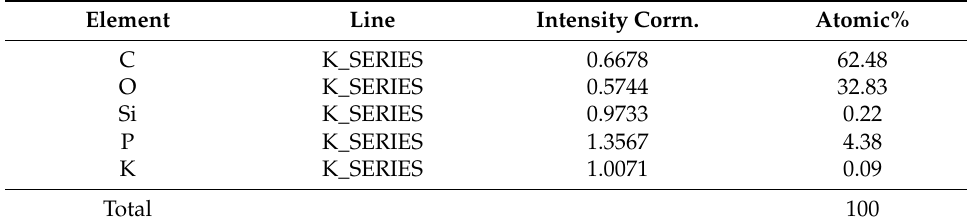
Figure 5. EDS spectrum of CNTs grown on the surface of RFSAC. Table 1. Elemental content quantitative